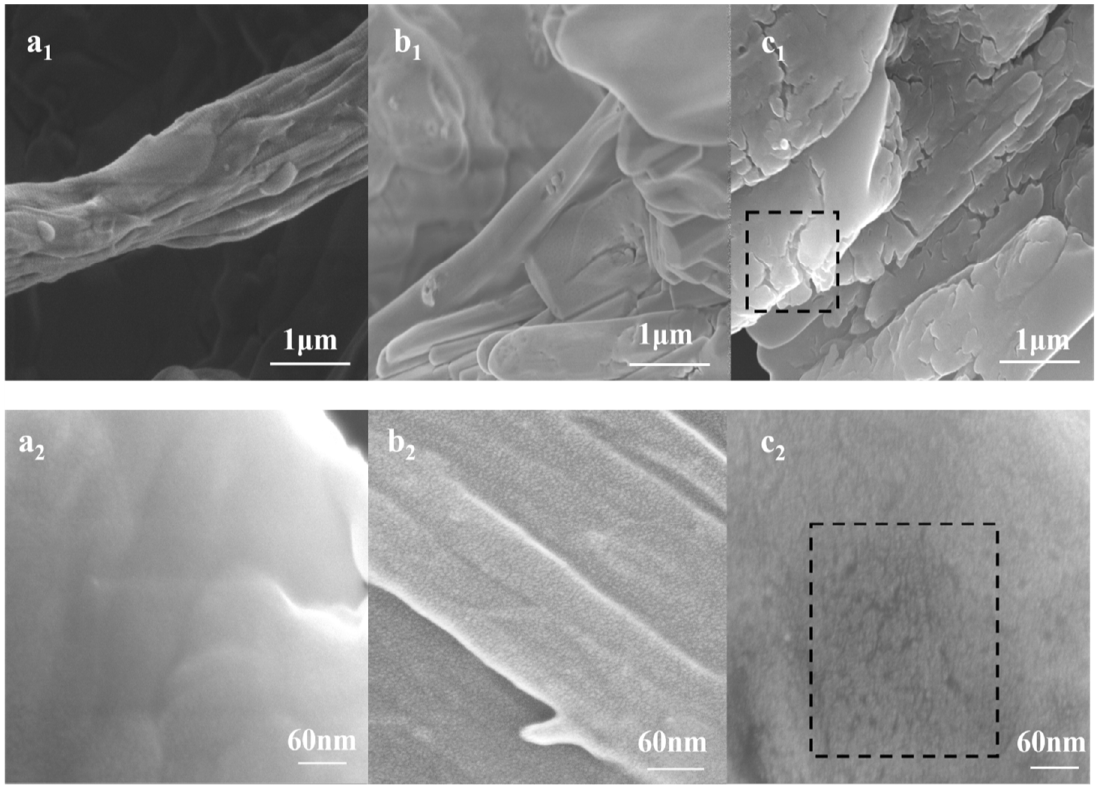
Figure 6. SEM analysis. ( a ) Type I collagen with 0 mg/mL collagenase I ( a 1 ×2000, a 2 ×300,000). ( b ) Type I collagen with 0.02 mg/mL collagenase I ( b 1 ×2000, b 2 ×300,000) ( c ) Type I collagen with 0.12 ( b ) Type I collagen with 0.02 mg/mL collagenase I ( b 1 × 2000, b 2 × 300,000) ( c ) Type I collagen with mg/mL collagenase I ( c 1 ×2,000, c 2 ×300,000). 0.12 mg/mL collagenase I ( c 1 × 2,000, c 2 ×